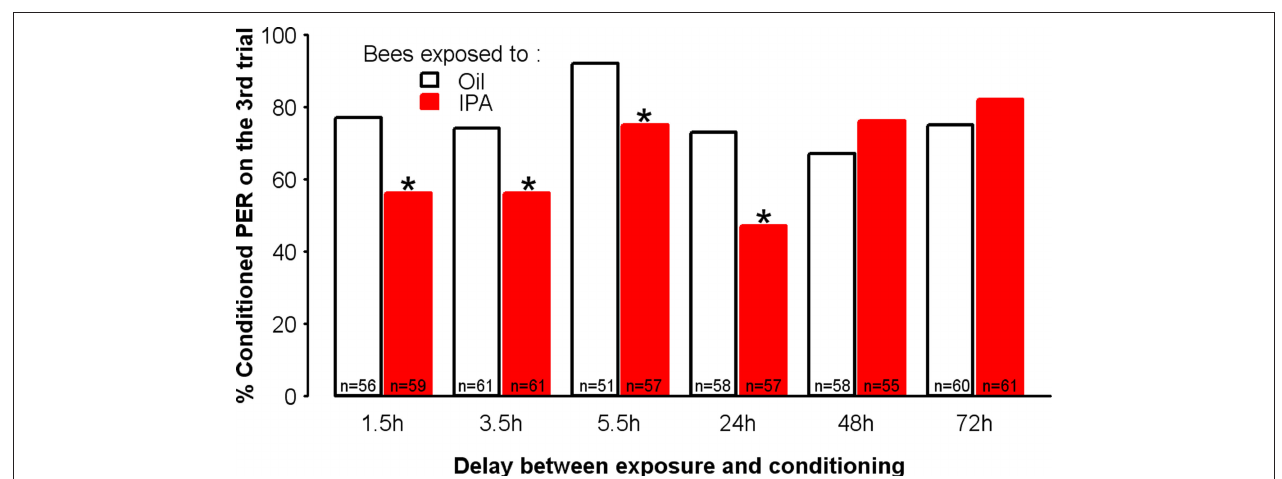
conditioning that varied for each group. Compared with controls ( Oil ), learning was impaired for delays up to 24 h. By contrast, for delays longer than 24 h, no significant impairment of learning was found. * p < 0.05 (as compared with respective Oil control